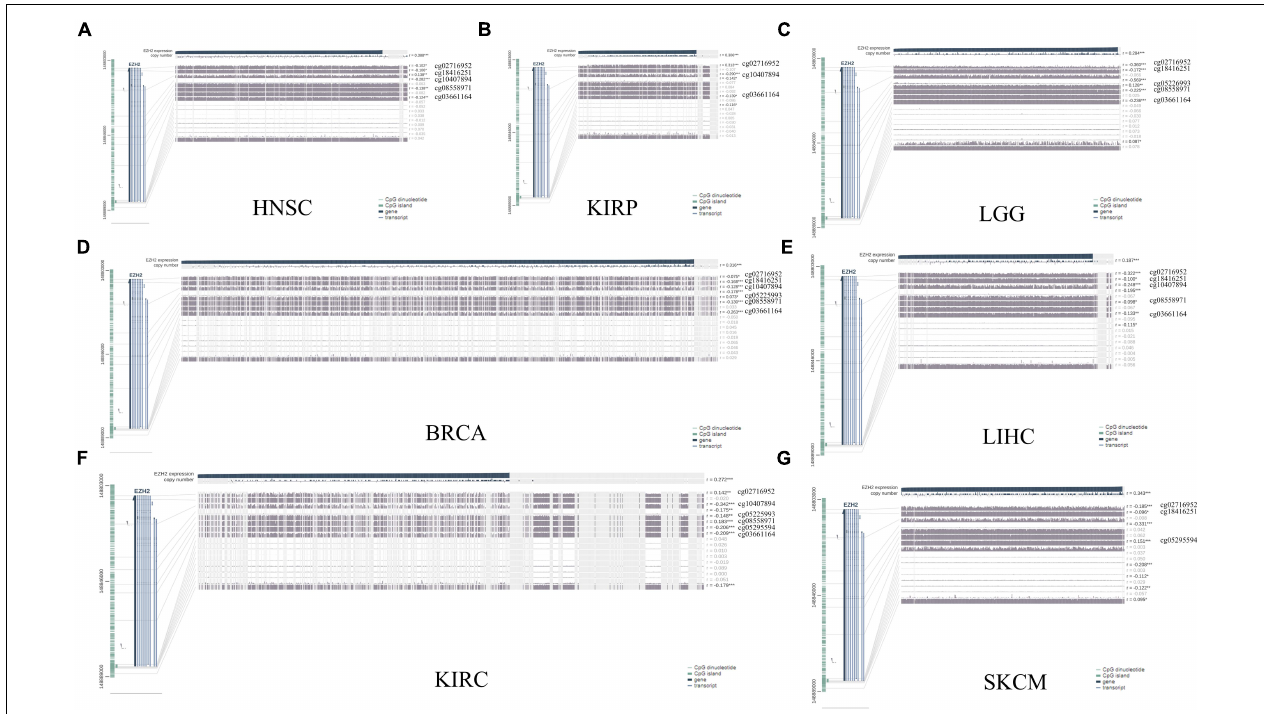
FIGURE 6 | DNA methylation analysis of EZH2 in (A) HNSC, (B) KIRP, (C) LGG, (D) BRCA, (E) LIHC, (F) KIRC, and (G) SKCM. * P < 0.05, ** P < 0.01, *** P < 0.001.